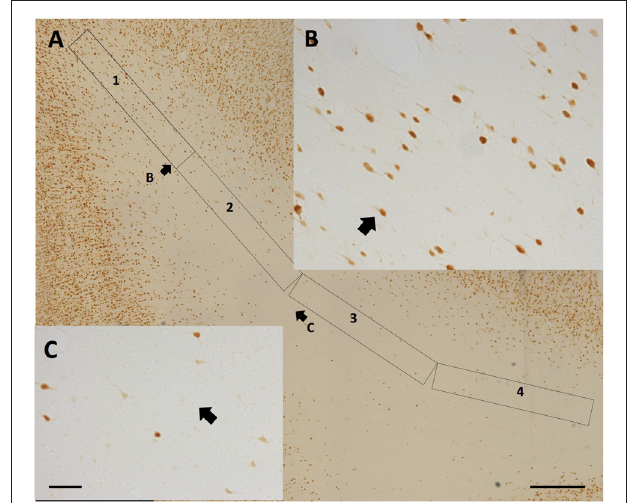
FIGURE 6 | (A) Representative 4-zone (1.125 mm long) rectangular counting frame, for determining WMN density as a function of distance from the gyral crown (at upper left). Zones 3 and 4 are tilted slightly, in order to remain near the middle of the gyrus. (B) Higher magnification from the distal portion of zone 1. (C) Higher magnification from the proximal portion of zone 3. Short arrows in (A,B) and (A,C) indicate corresponding fields. Scale bars = 500 µ m in (A) ; 50 µ m in (B,C) .